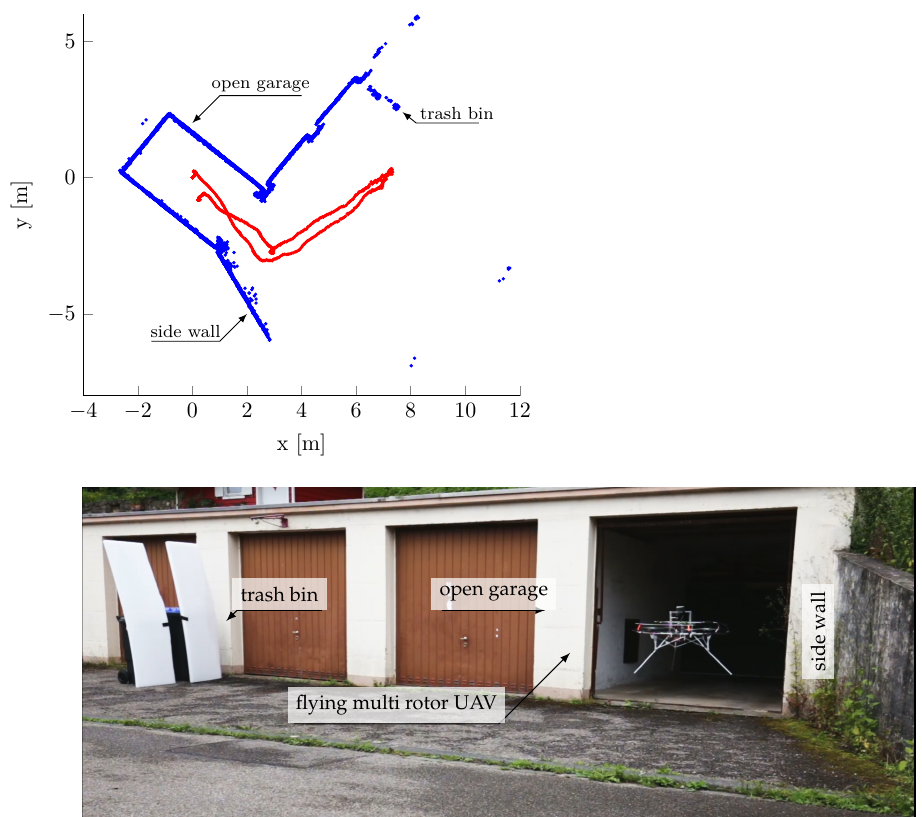
Figure 6. The map was generated during a three-minute outdoor flight in the environment shown in the picture. When comparing the photo with the map one needs to take into account that the map is shown in a NED (north-east-down) frame and thus it is a bottom-up view. A video of the flight can be found online